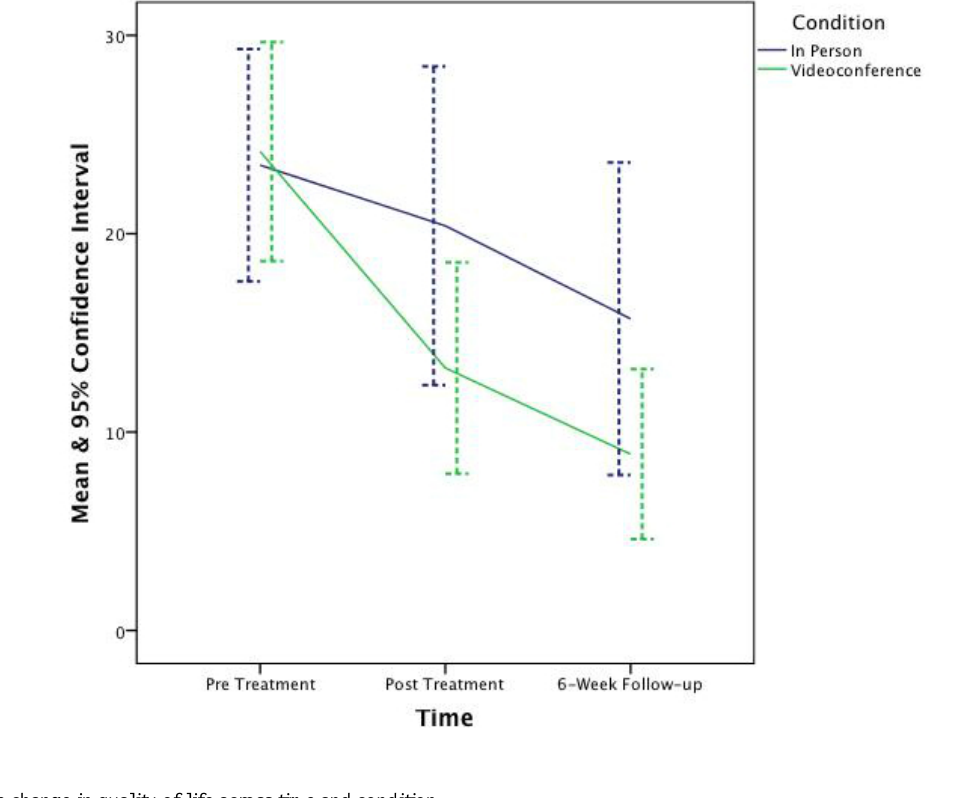
Figure 4. The change in symptoms of stress across time and condition.